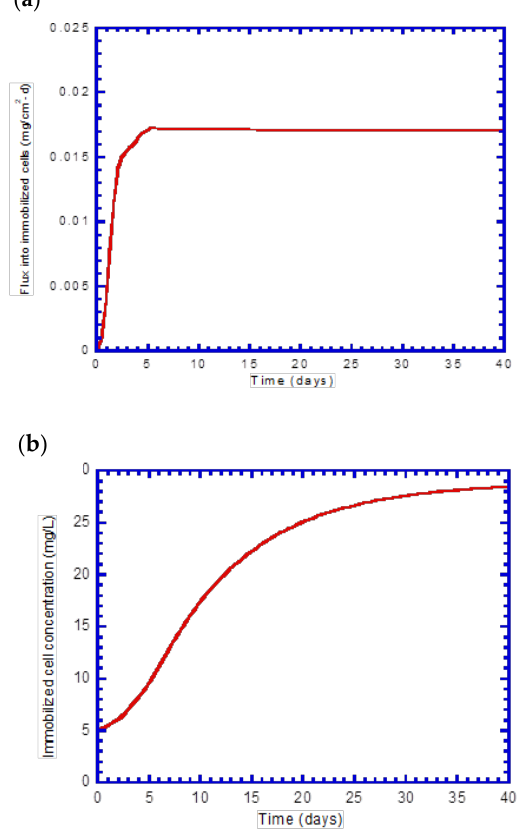
Figure 12. Model prediction versus time of ( a ) phenol flux into beads and ( b ) immobilized cells growth.